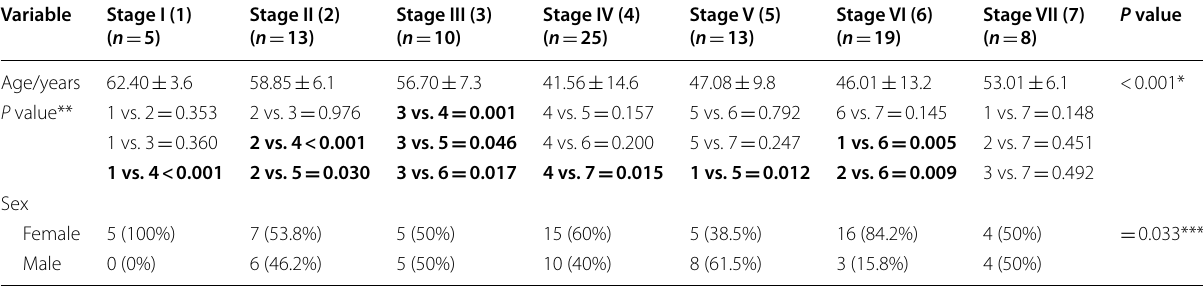
Table 2 Demographic and lymphedema stages of cases and control